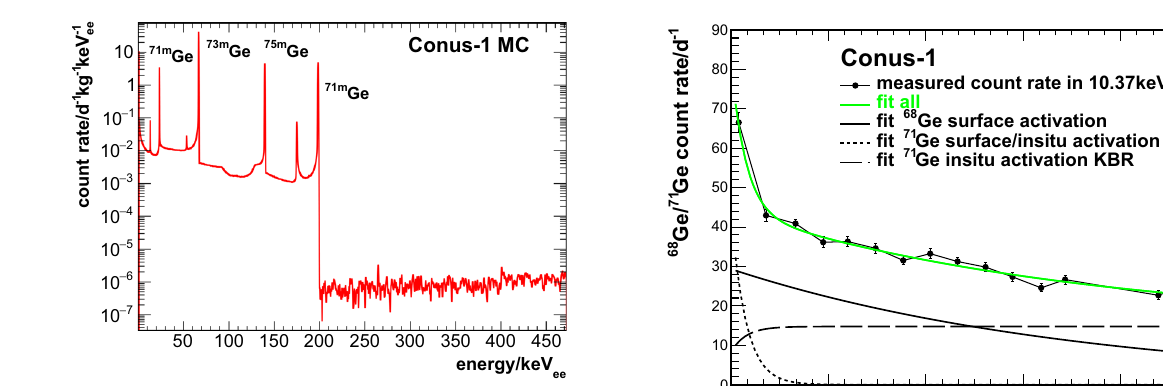
Fig. 10 MC of the decay of the three metastable states in Ge which induce visible background lines in the CONUS data. The isotopes are created by neutron capture of μ -induced neutrons and have a half-life longer than the μ -veto window. The MC spectra are scaled by the mea- sured line count rates during data collectionof RUN-1; for each isotope, at least one line is observed sured data, for example, in the blue spectrum of Fig.2. From the MC it becomes evident that the impact of this background is as low as (0.05 ± 0.01)d − 1 kg − 1 in [0.4, 1]keV ee (mea-